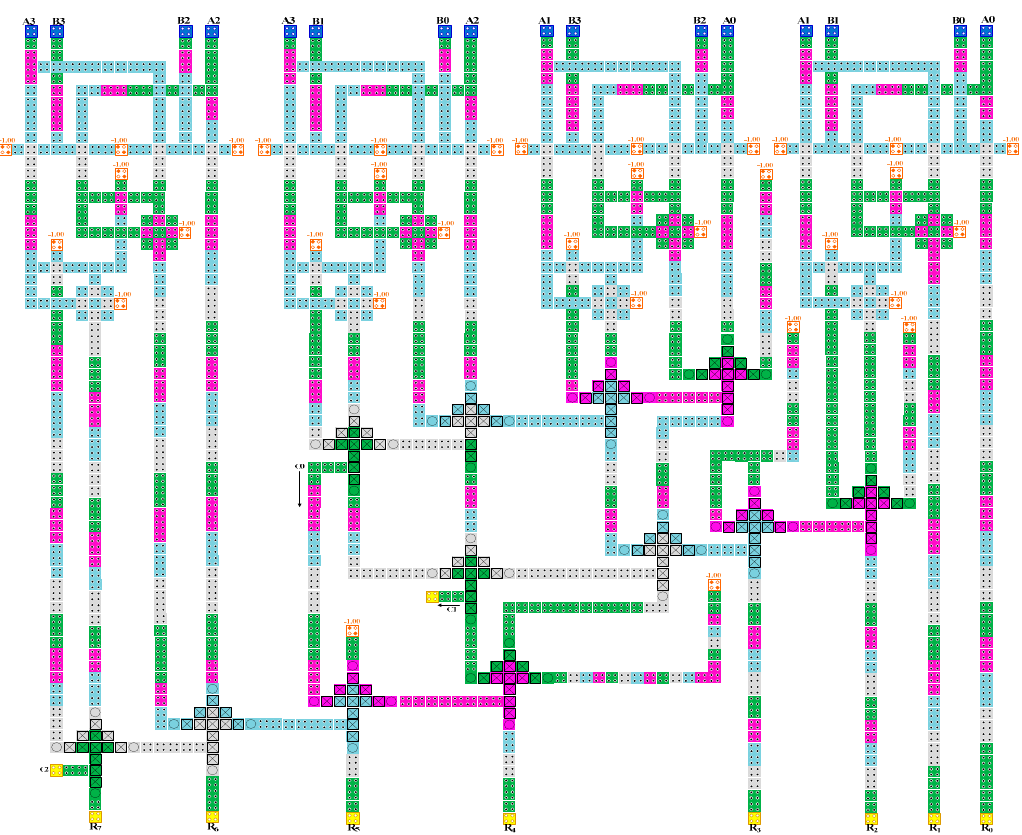
Figure 12. Design of the proposed 4 × 4 Vedic multiplier.